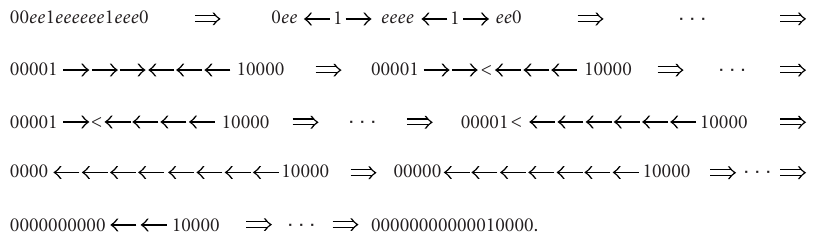
Figure 3.1. Toy particle evolution in 2-detector case.